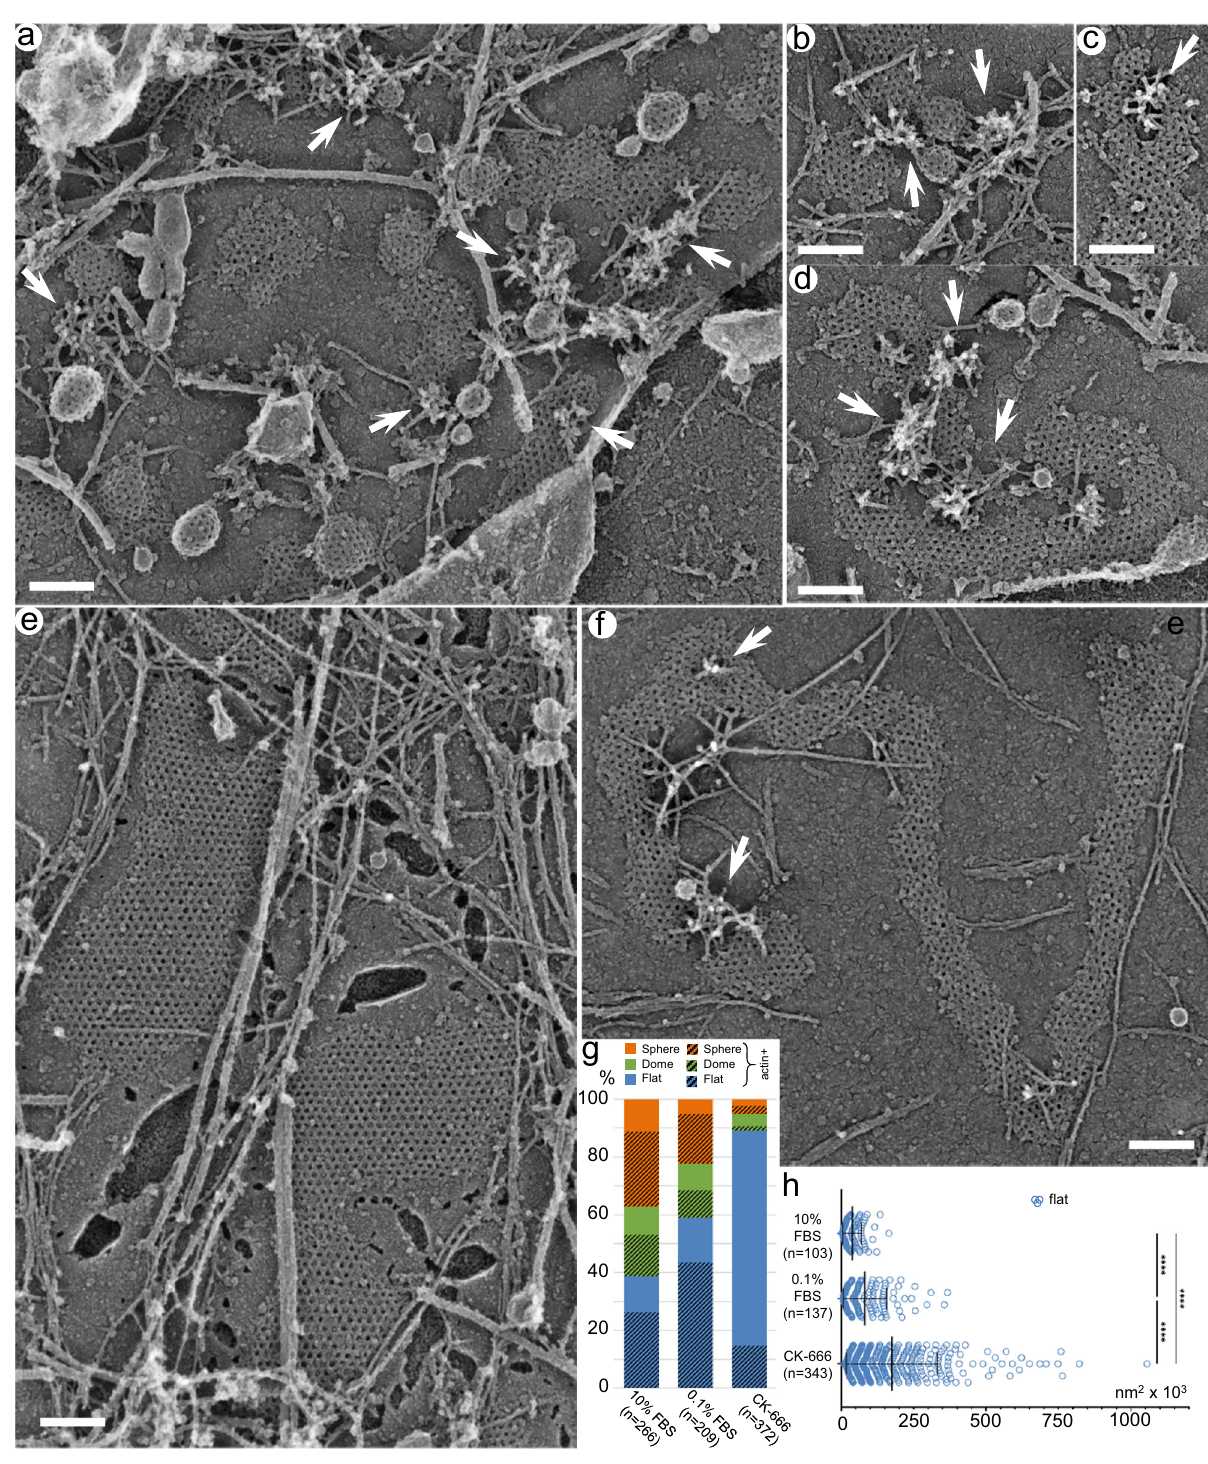
Fig. 3 | Inhibition of the Arp2/3 complex results in accumulation of large fl at CCSs at the expense of other CCS categories. a – d Control PtK2 cells cultured in the presence of0.1% FBS and DMSOexhibit fl at, dome-shaped and spherical CCSs, someofwhichareassociatedwithbranchedactinnetworks(arrows). e , f PtK2cells treated with 200 μ M CK-666 in the presence of 0.1% FBS contain very large fl at CCSs occasionally associated with small remaining patches of branched actin lattice seams (Fig. 5c – j, yellow arrowheads), suggesting that bran- involved in the division of fl at CCSs by invading into CCS seams and pushing them apart. The decrease in the area of fl at CCSs that was